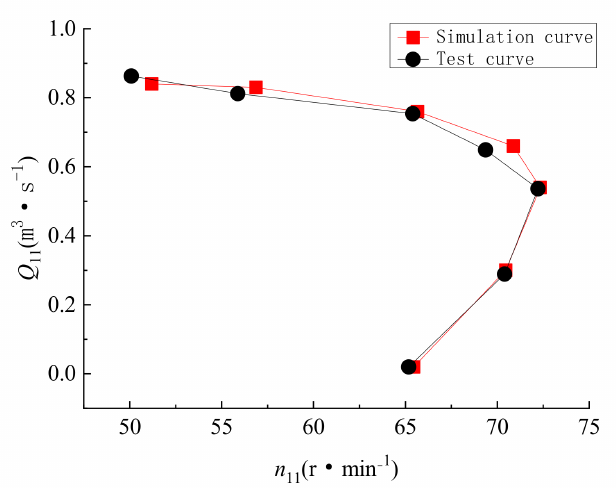
Figure 8. Comparison of experimental and simulation